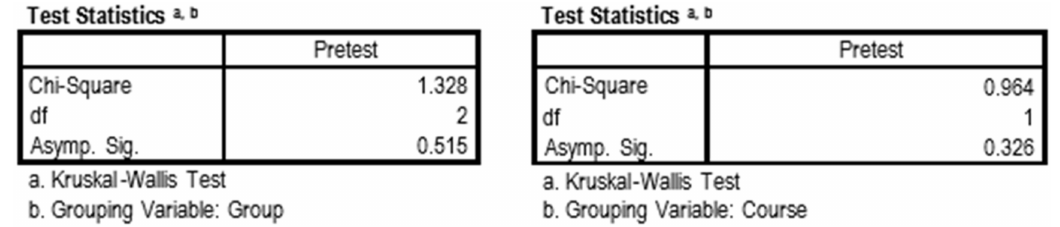
Figure 3. Kruskal–Wallis test. Grouping variable: Group and